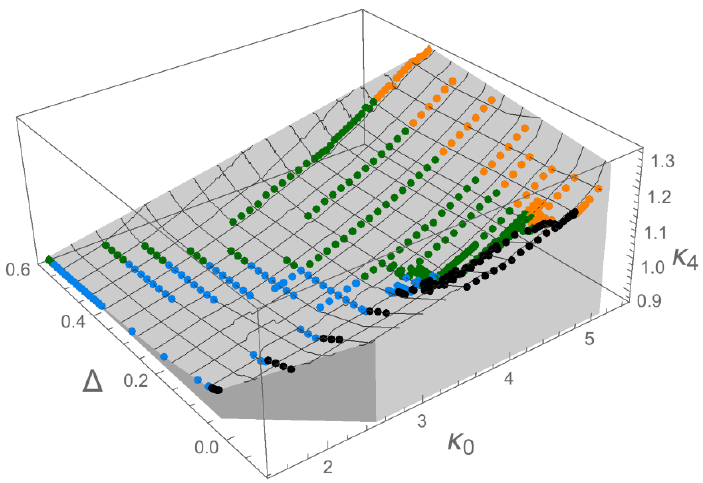
Figure 2 . The critical surface (cid:20) c spacetime topology M = T 3 (cid:2) S 1 . Colors denote various phases of geometry described in section 5.